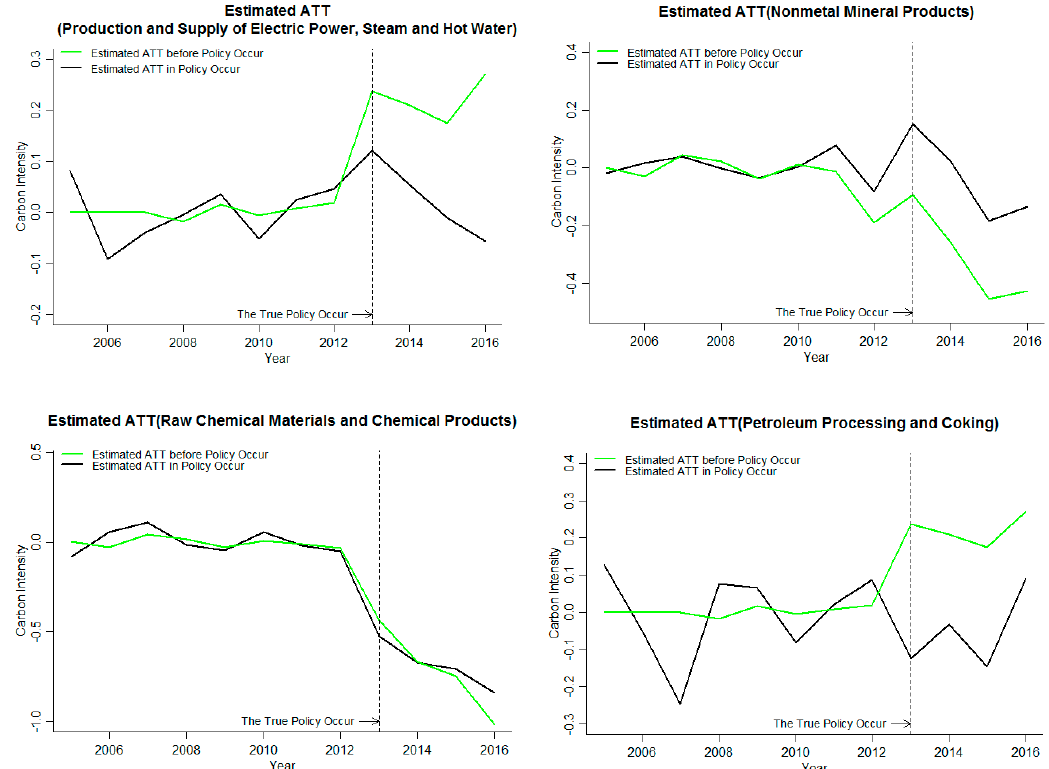
Figure 7. Industry robustness test results in Beijing.